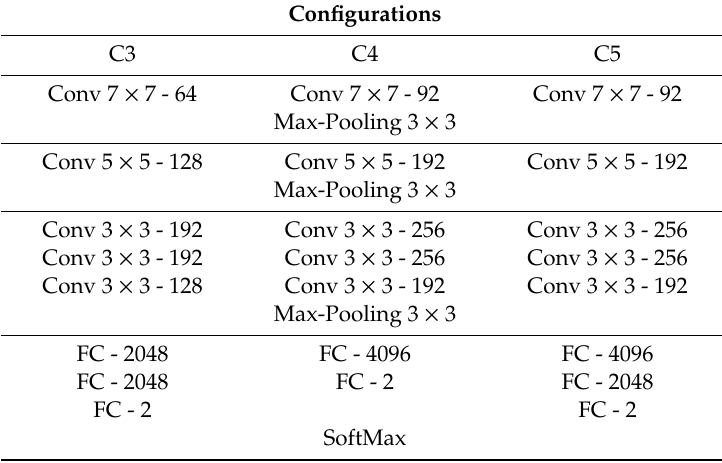
Table 3. Proposed networks based on ZF Net—Using half of the database.